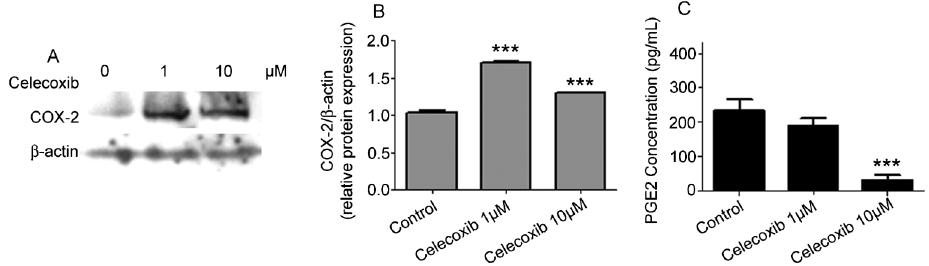
Figure 3. Celecoxib modulates COX-2 protein translational rates in cardiac H9c2 cells. A , Western blot analyses of COX-2 protein level after celecoxib-specific treatments. The results are from one representative experiment of three performed assays that showed similar patterns. B , Quantitative analysis of the Western blots. C , Supernatant of treated cells was used for prostaglandin E2 (PGE2) measurement. ***P , 0.001 compared to control ( B ) or control and 1 m M ( C ) (Dunnett